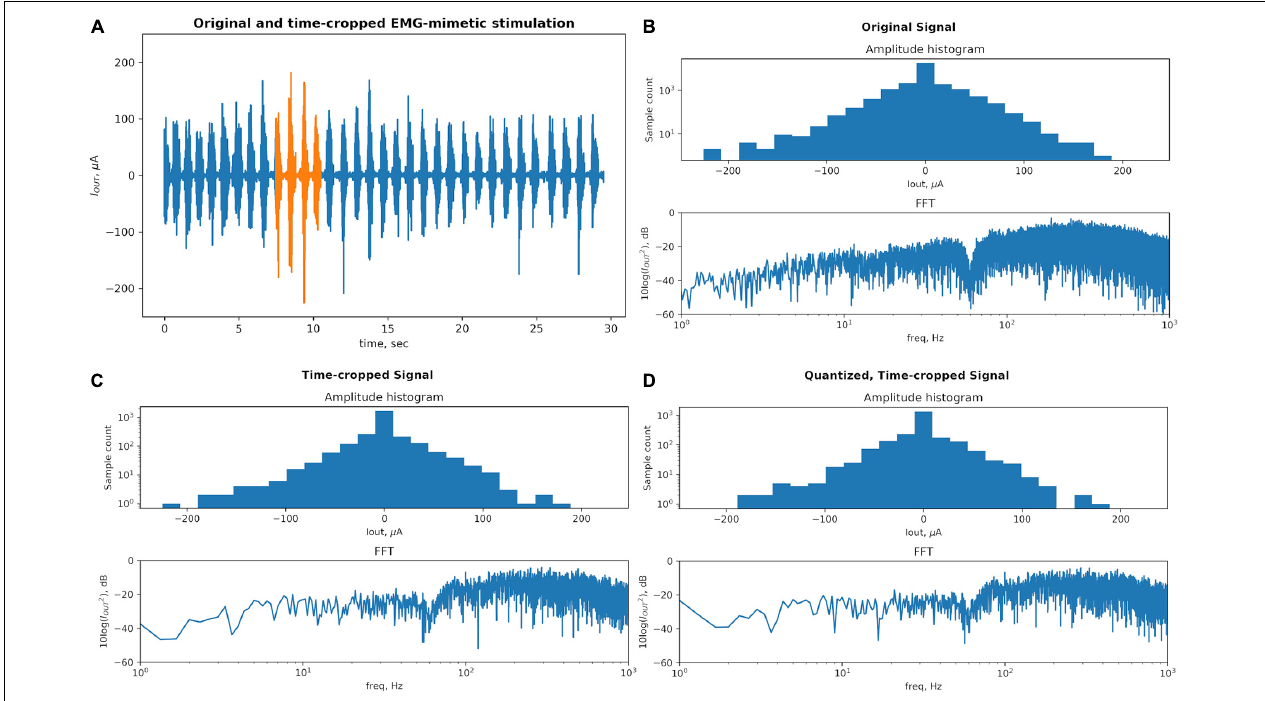
FIGURE 2 | A physiological recording used as a biomimetic stimulation protocol Dynamic Stimulation (DS) is transformed to conform to the typical hardware limitations of the System-on-Chip (SoC)-based stimulators. The key characteristics responsible for therapeutic efficacy of this signal (amplitude and frequency modulations) are preserved through the transformation process. (A) Original signal (blue) contains bursts corresponding to rhythmic stepping of an animal on a treadmill. The signal was strategically time-cropped, from 30 to 3 s, to preserve the wide range of peak amplitudes and frequencies while saving memory space in the proposed stimulator system. (B) Original signal’s statistic of peak amplitudes and frequency content defines a baseline for the comparison. The dip in the spectrum at 60 Hz is created by the “line” noise filter. (C) The time-cropped signal’s peak amplitude counts and the number of FFT samples are reduced proportionally with the length. The general shape of the histogram and frequency content is notably generally unchanged. A dip at the ∼ 140 µ A bin results from a reduced number of high amplitude peaks in the time-cropped signal as it contains less high amplitude bursts as compared to the original signal. (D) The quantization step reduces the resolution from the 14-bit precision of the recording amplifier that captured the original signal to the 8-bit output resolution of the neural stimulator SoC employed in this work. The amplitude statistics are and FFT are notably unchanged and this final signal is used in the proposed system and the in vivo